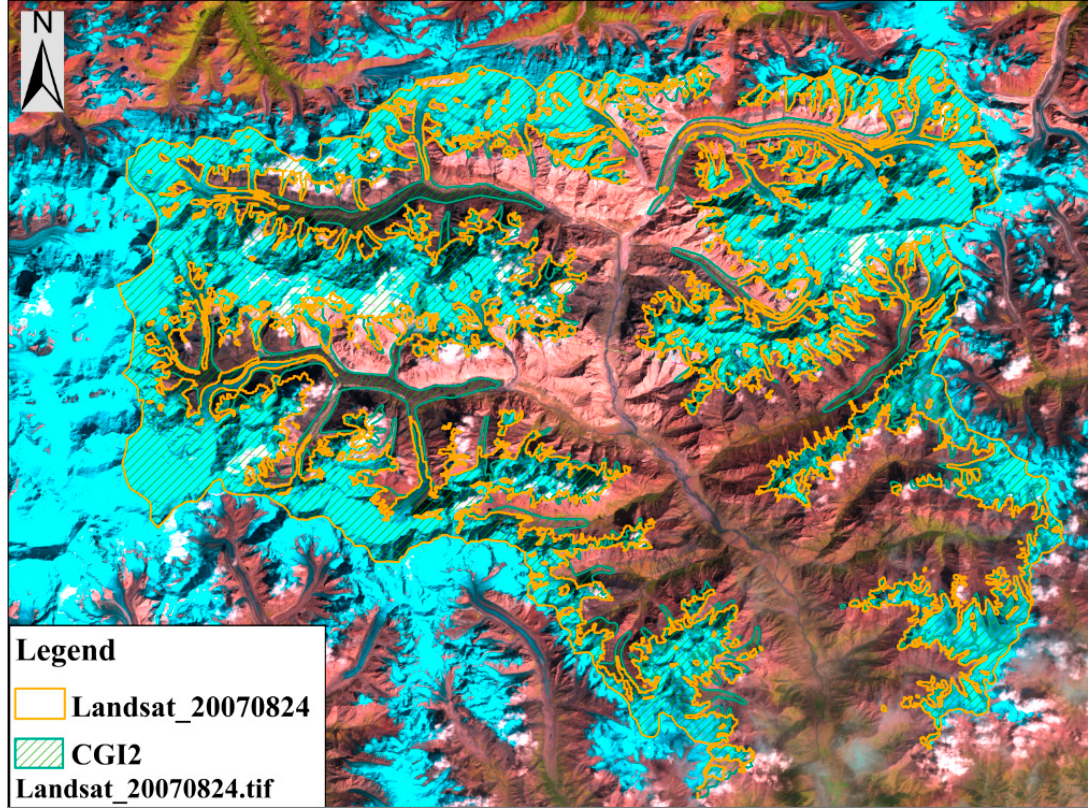
Figure 5. Comparison of glacier outlines of CGI2 (blue polygon) and those derived from Landsat images (yellow polygons and background images) in this study using object-based classification in the Muzart Glacier catchment on 24 August 2007. Table 2. Statistics of glacier areas (km 2 ) based on CGI2 and those extracted from Landsat images in the Muzart Glacier catchment and the entire Central Tianshan Mountain during 2007–2013. CGI2 does not cover the entire Central Tianshan; its statistics not